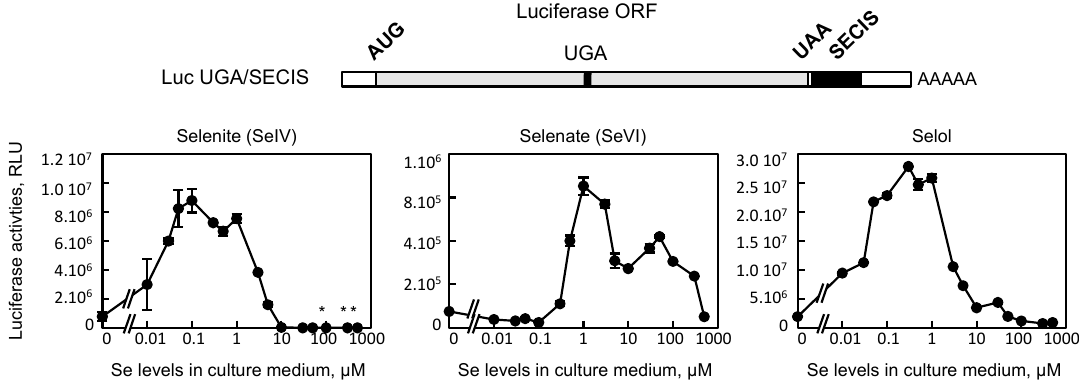
Figure 5. Evaluation of selenocysteine insertion e ffi ciency in response to selenium supplementation in HEK293 cells. The luciferase activities from the stably expressing cell lines are measured from cells grown in increasing concentration of selenite, selenate or Selol in the culture media (from 10 nM up to 500 µ M). Luciferase activities are expressed relative to protein concentration (relative luciferase unit, RLU). In several extracts, due to selenium toxicity, the protein recovery is too low to allow precise selenium detection and normalization, as indicated by an asterisk. A schematic of the luciferase construct is shown on top of histograms. AUG, start codon; UGA, selenocysteine codon; UAA, stop codon; SECIS, selenocysteine insertion sequence.